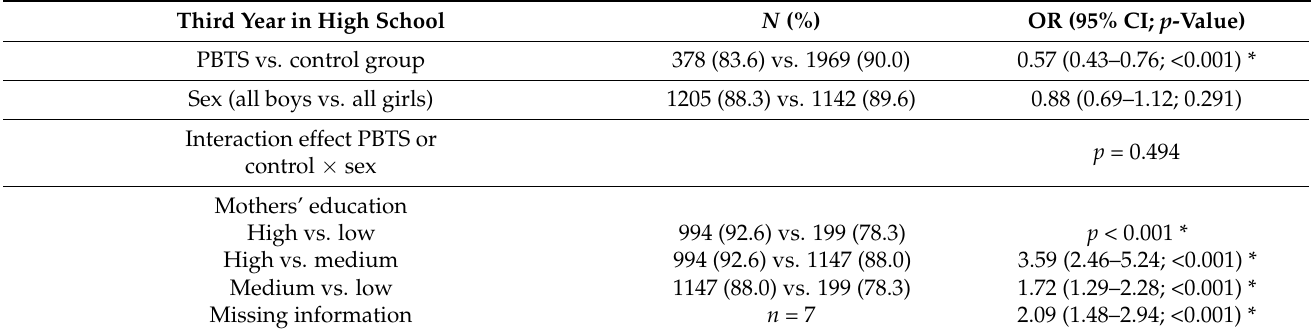
Table 3. Post-compulsory education any time between 2006–2017 for pediatric brain tumor survivors (PBTS) and controls. Statistically significant results are marked with